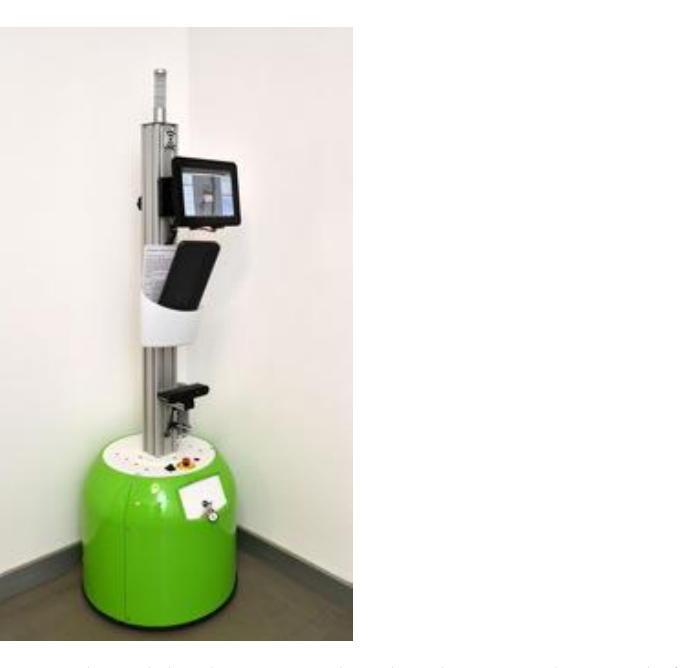
Figure 1. The mobile robotic system based on the MetraLabs Tory platform.